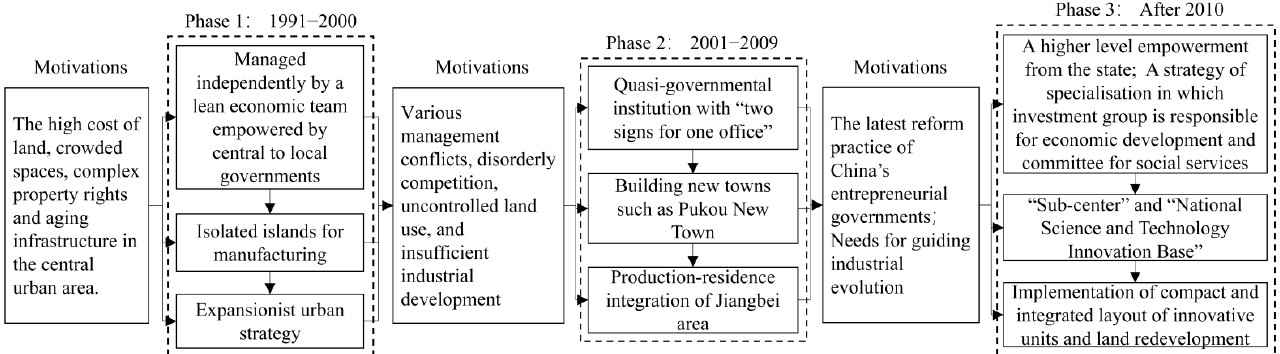
Figure 8. Evolution of multi-dimensional characteristics of Jiangbei development in Nanjing by development zones.